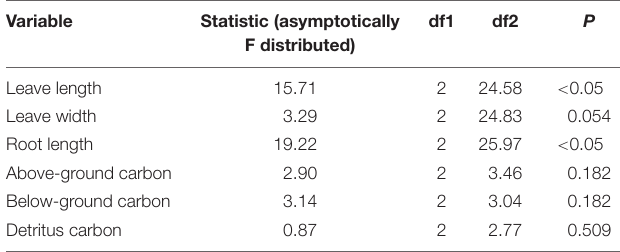
TABLE 1 | Statistical analysis of effects of different light intensities on seagrass parameters.